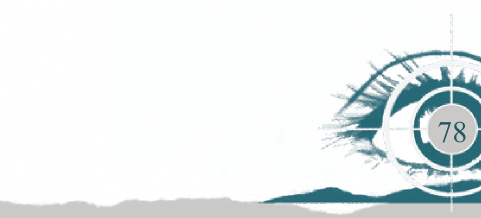
Key words: Optometric practice in South